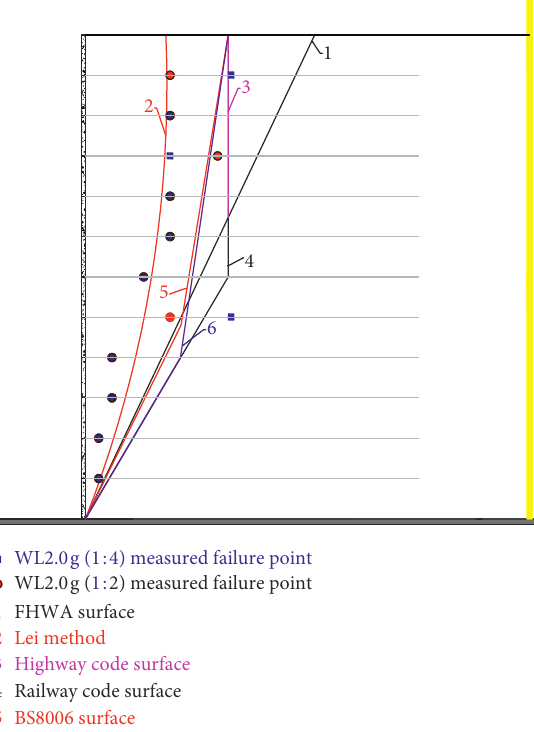
Figure 21: Potential failure surface calculation method of specimen